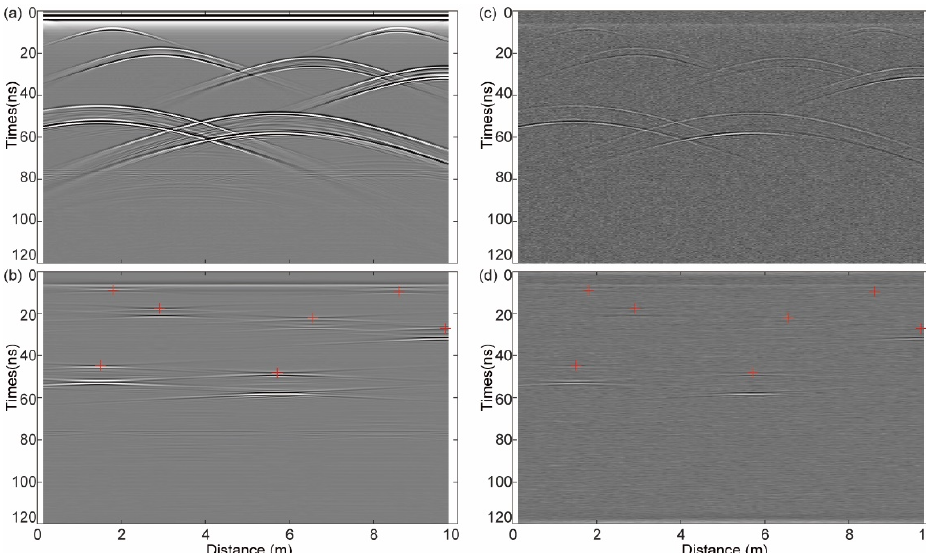
Figure 10. ( a ) Forward result; ( b ) the local correlation results; ( c ) forward result with Gaussian noise added; ( d ) the local correlation results with Gaussian noise added. The red-cross indicates the vertex position of the diffractions and the white color indicates the maximum value of local correlation.